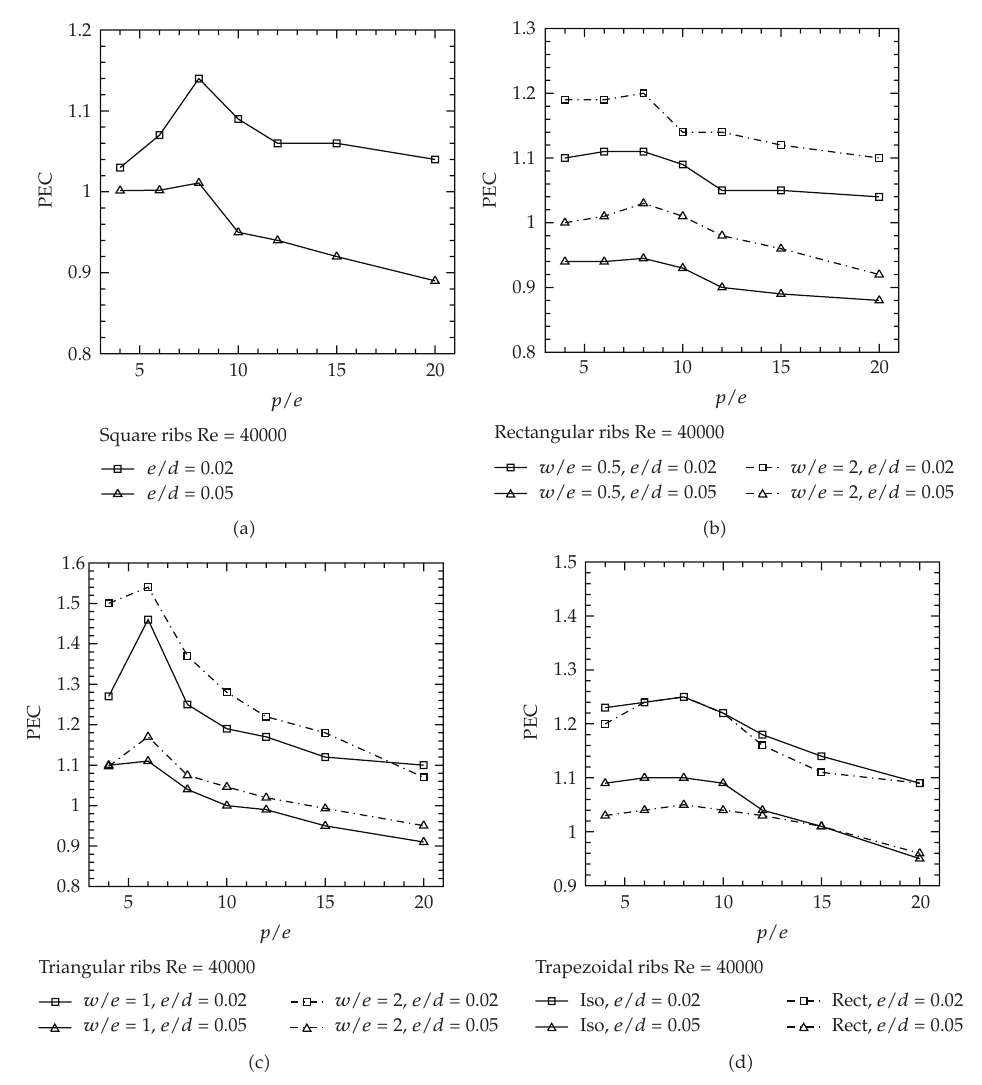
Figure 9: PEC index profiles as a function of p/e at Re (cid:8) 40000, for e/d (cid:8) 0 . 02 and 0.05: (cid:6) a (cid:7) square-ribs, (cid:6) b (cid:7) rectangular ribs with w/e (cid:8) 0 . 5 and 2.0, (cid:6) c (cid:7) triangular ribs with w/e (cid:8) 1 . 0 and 2.0, and (cid:6) d (cid:7) isosceles and rectangular trapezoidal ribs with w/e (cid:8) 2 .